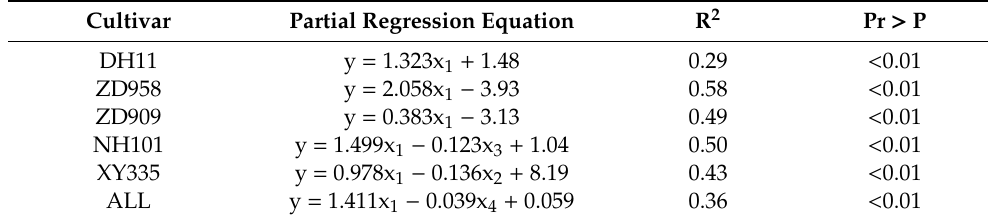
Table 5. Results of the stepwise regression between final leaf numbers and climatic factors for each maize cultivar during the vegetative growth